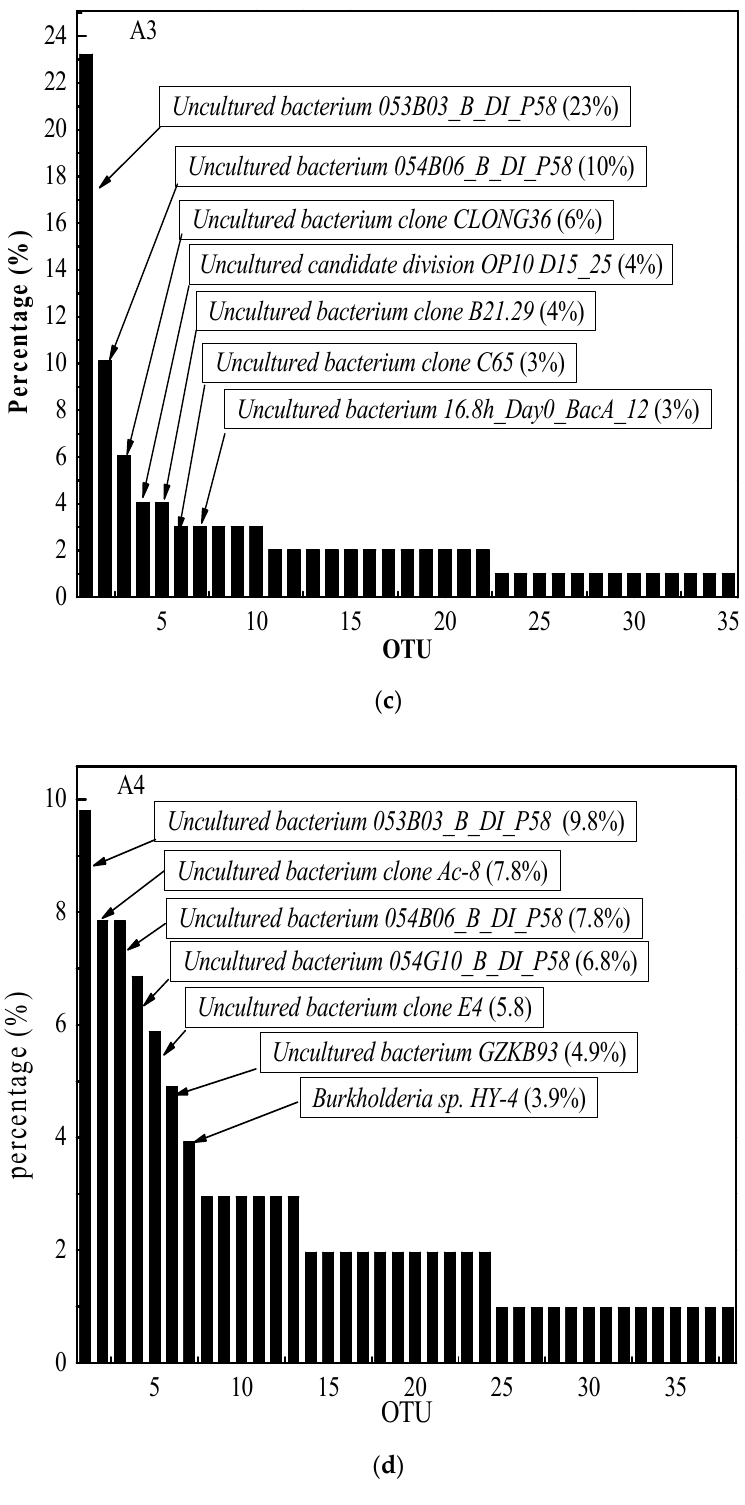
Figure 1. The total bacterial community in compartments of ABR ( a ) chamber A1, ( b ) chamber A2, ( c ) chamber A3, and ( d ) chamber A4.